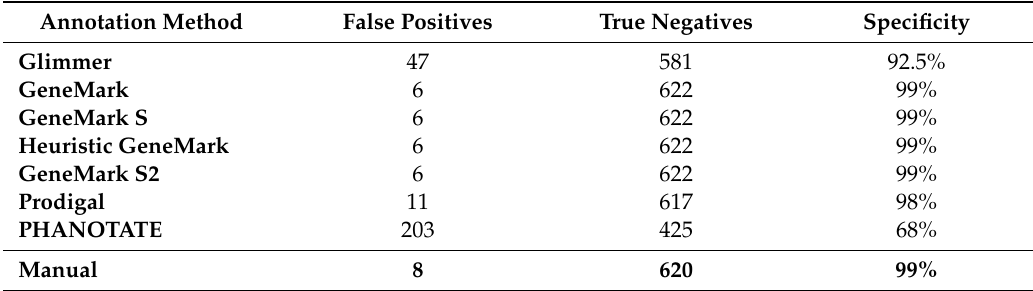
Table 5. Results of annotation of a randomly generated nucleotide sequence by the manual curation method and auto-annotation